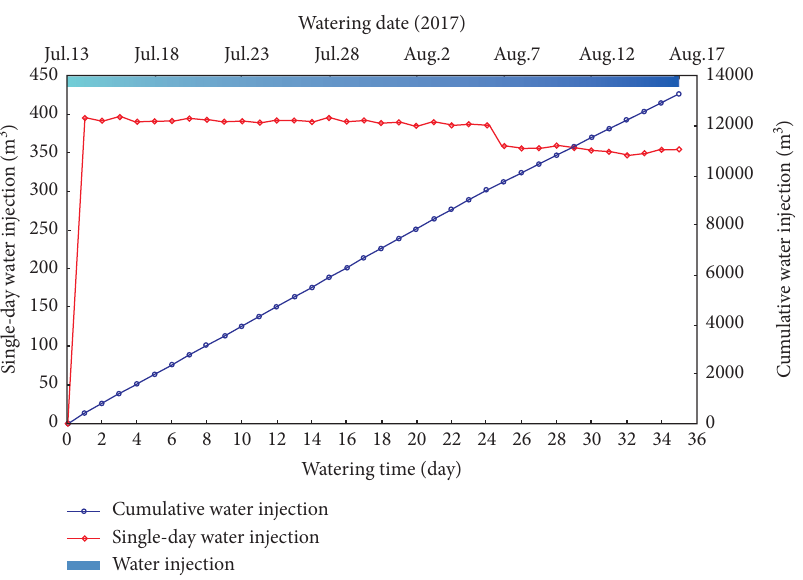
Figure 5: The relation between single-day water injection and cumulative water